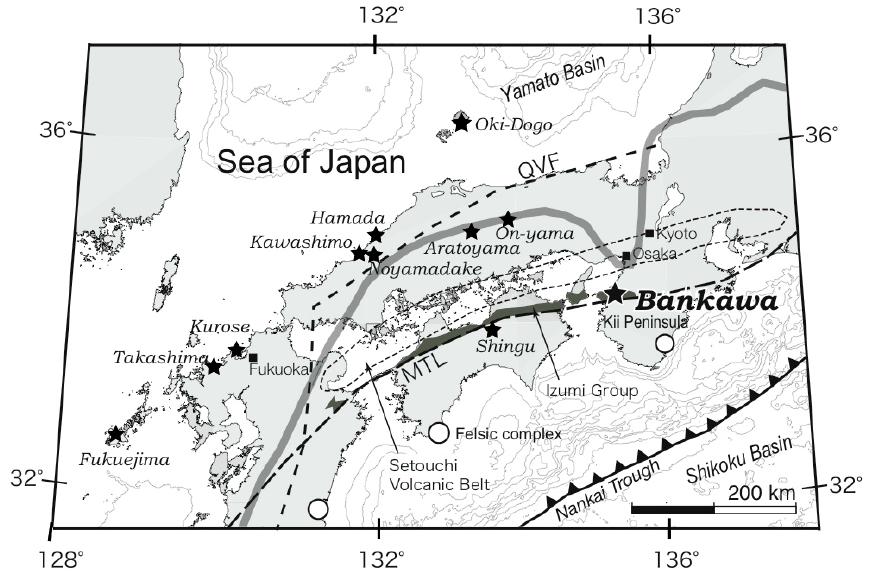
Figure 1. Location of the Bankawa outcrop in the Kii Peninsula, southwestern Japan. Main mantle xenolith localities (black star) are after Arai et al. [15]. Distributions of the Setouchi Volcanic Belt and felsic complexes (open circle) [25] and the Izumi Group [26] are shown. QVF and MTL are Quaternary volcanic front and Median Tectonic Line [27], respectively. Note that Bankawa is one the most Pacific- ward localities of mantle xenoliths in the SW Japan arc. The position of the edge of the slab (Philippine Sea plate) (thick gray line) is after Nakajima and Hasegawa [28].